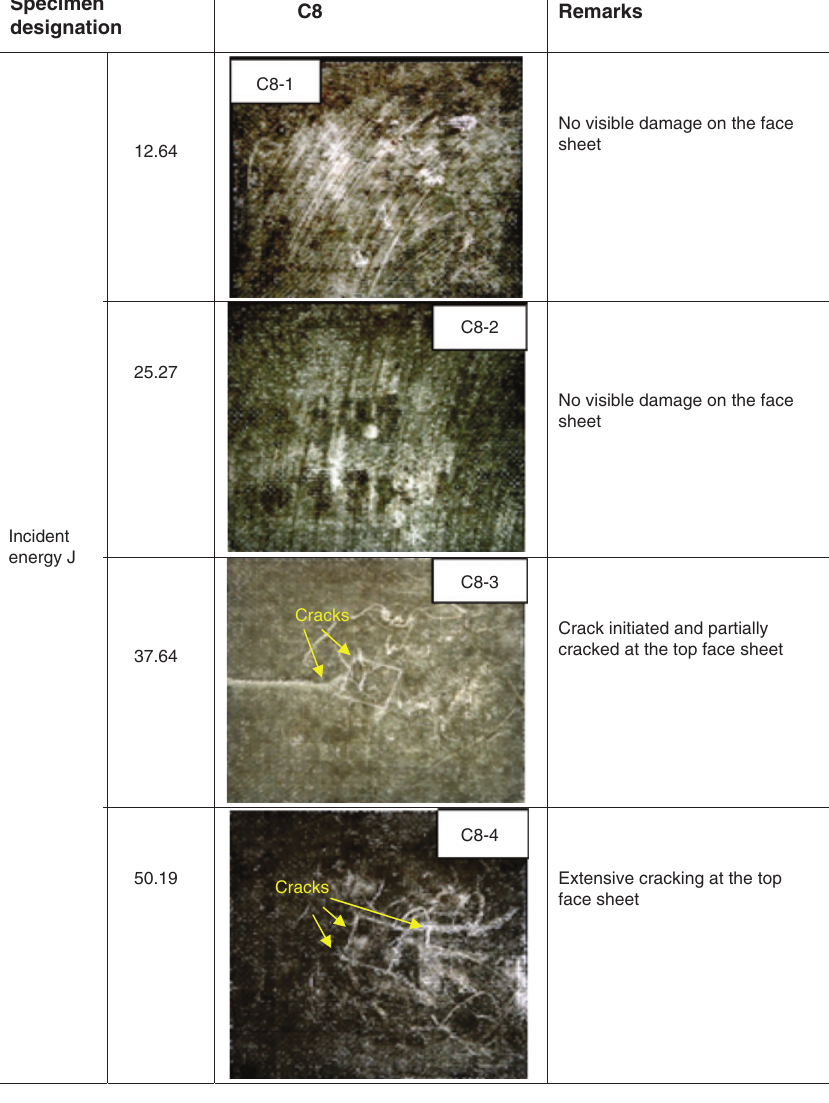
Figure 11 Post-impact images of specimen C8 at various energy